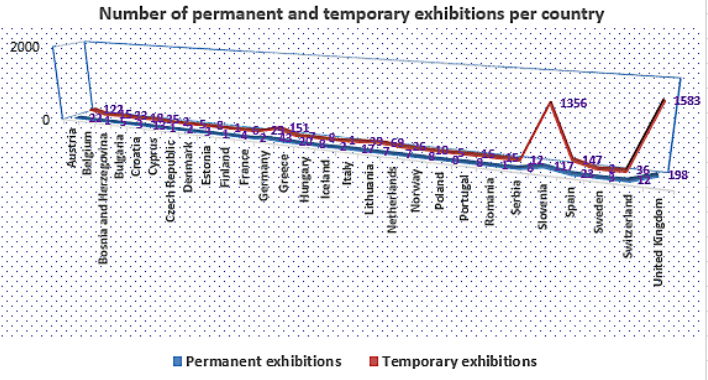
Figure 1. Number of permanent and temporary exhibitions per country (source: created by authors)